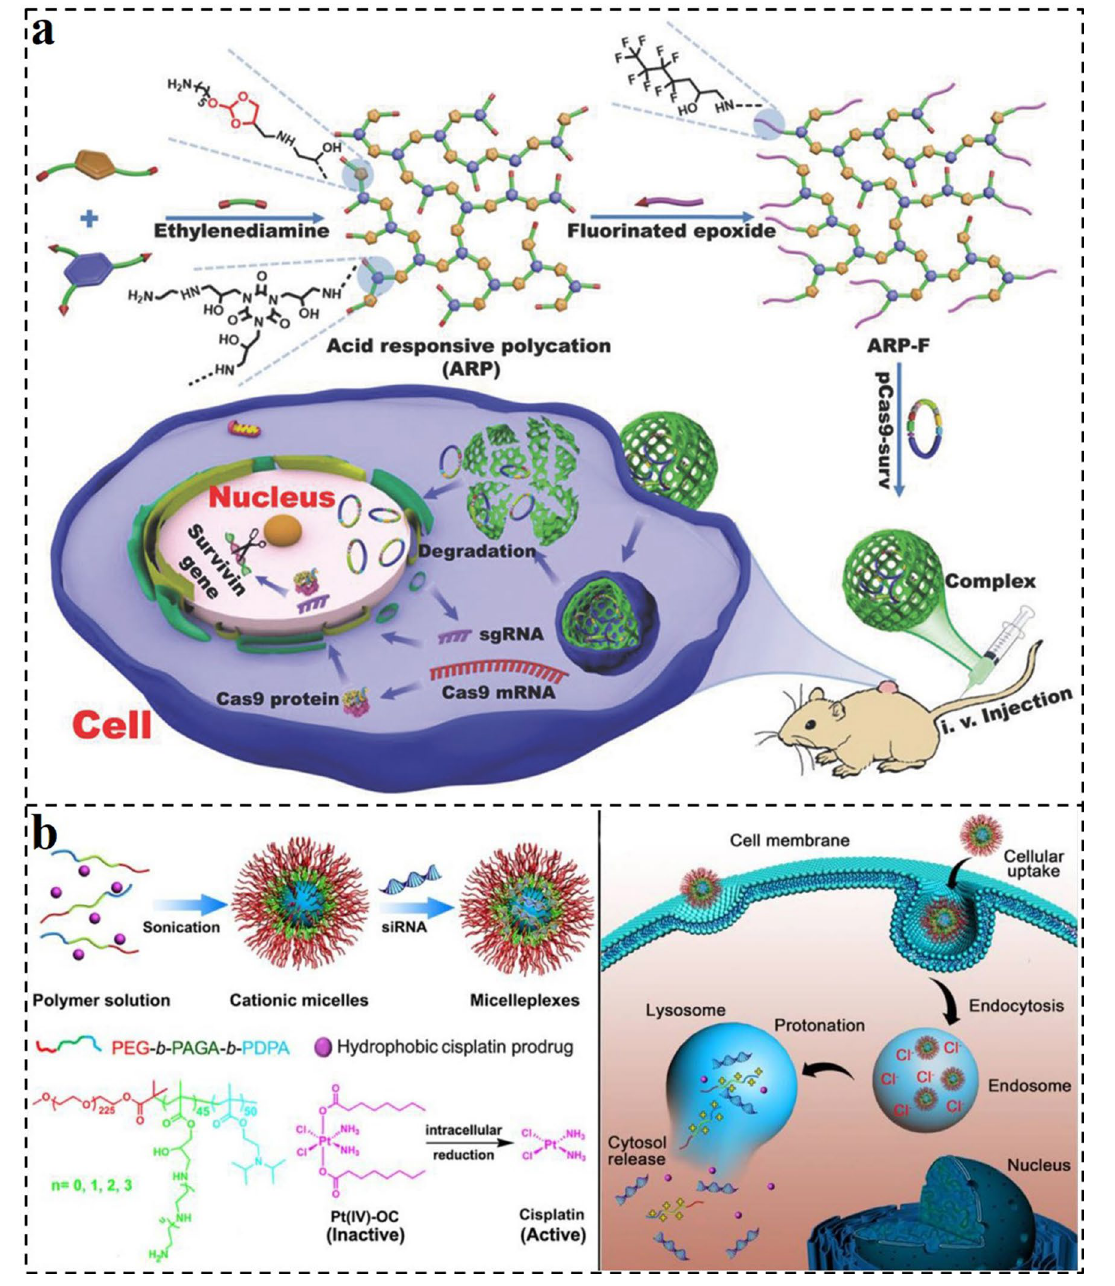
Fig. 4 a Schematic illustration of the preparation of fluorinated acid-responsive polycation (ARP-F) and its resultant plasmid (e.g., pCas9-surv) delivery process [155]. Copyright 2018, Wiley–VCH GmbH. b Schematic illustration of the preparation and intracellular activation of siRNA and cisplatin prodrug co-loaded pH-responsive micelleplexes [156]. Copyright 2016, Ivyspring